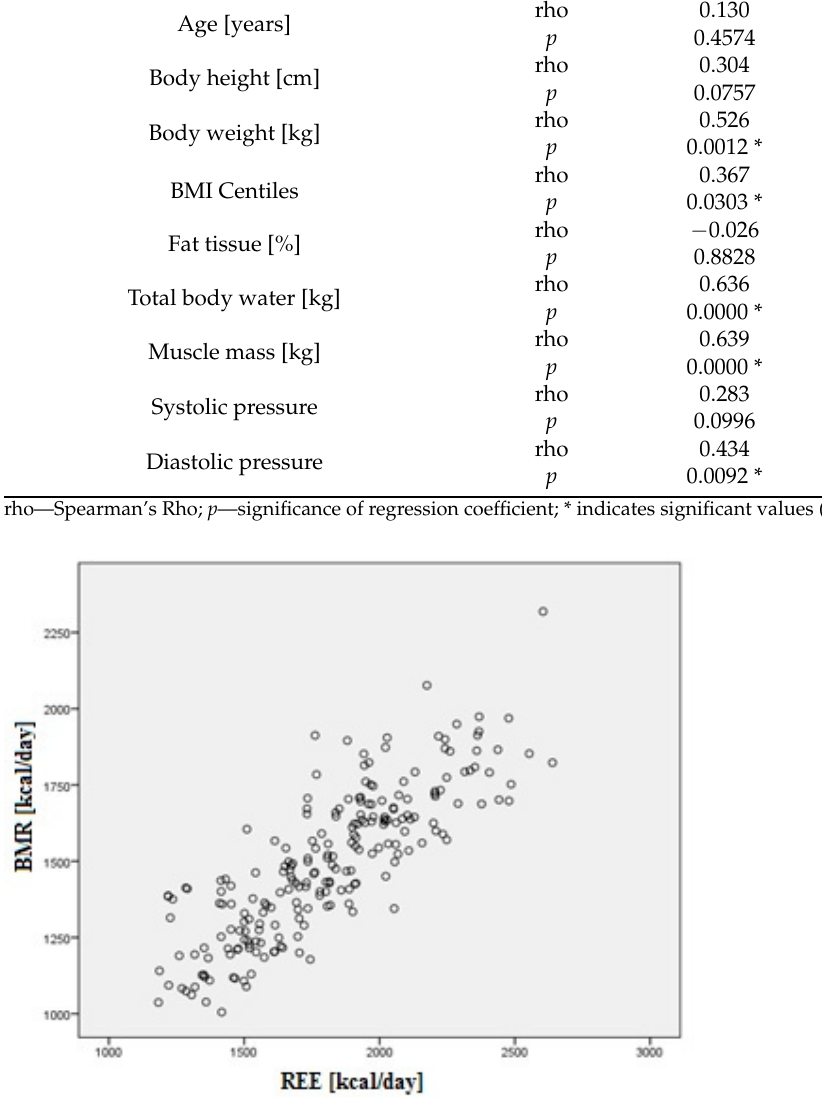
Figure 2. Correlation between the REE and the basal metabolic rate (BMR).